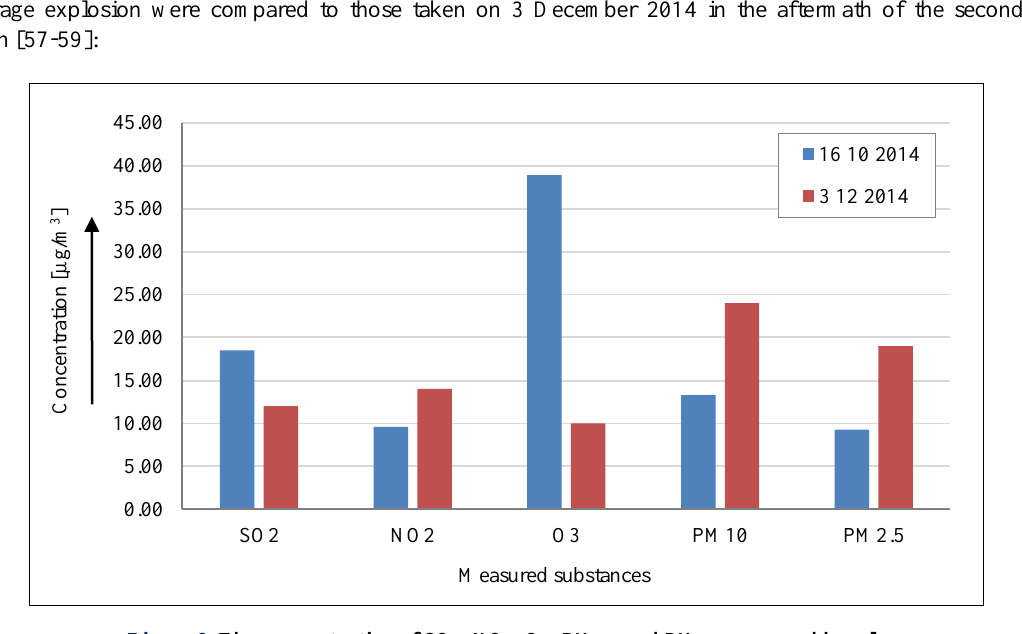
Figure 6. The concentration of SO 2 , NO 2 , O 3 , PM 10 , and PM 2.5 measured hourly